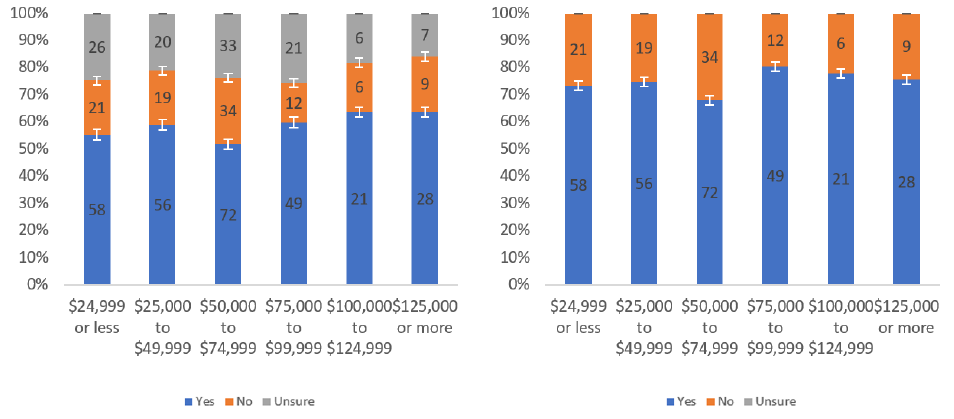
Figure 16. Responses regarding others’ willingness to review by income level including ( left ) and excluding ( right ) unsure responses.